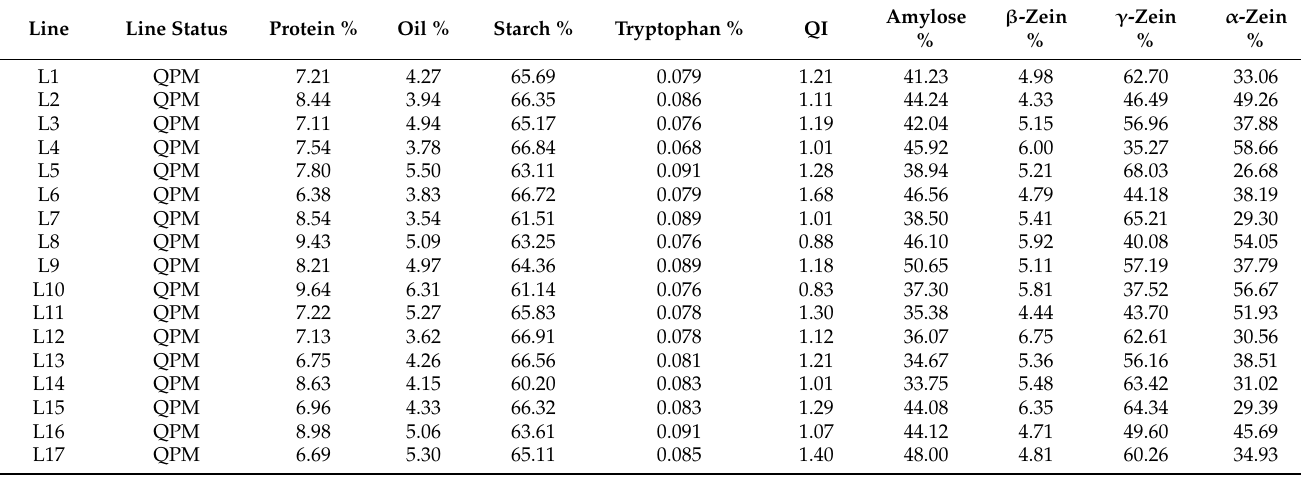
Table 3. Means of quality traits for 40 inbred lines analysed across four environments in Zimbabwe and South Africa during the 2017/2018 cropping